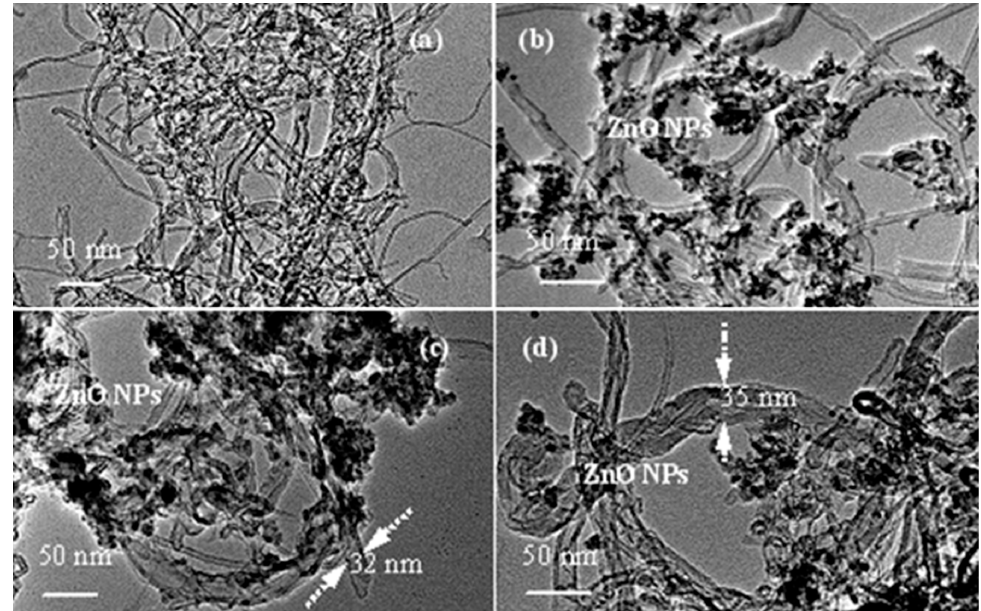
Figure 4. TEM images of (a) MWCNTs, (b) MWCNTs@ZnO, (c) C2 and (d) C3 nanohybrids.